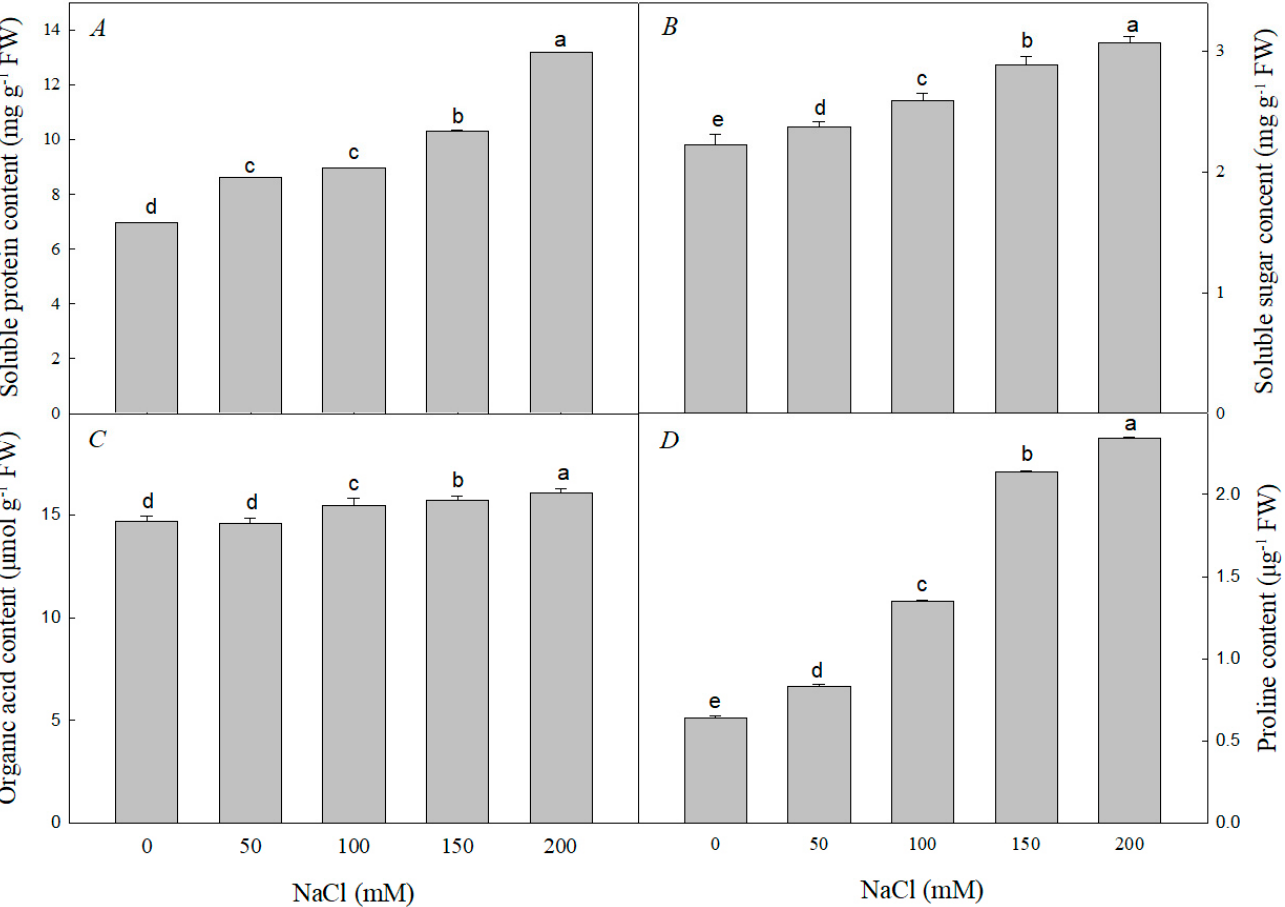
Figure 3. Effect of NaCl stress on the contents of soluble protein ( A ), soluble sugar ( B ), organic acids ( C ), and proline ( D ) of R. pseudoacacia seedlings. Values are mean ± SD of five biological replicates. Bars with different letters are significantly different at p < 0.05 according to Duncan’s multiple range tests.